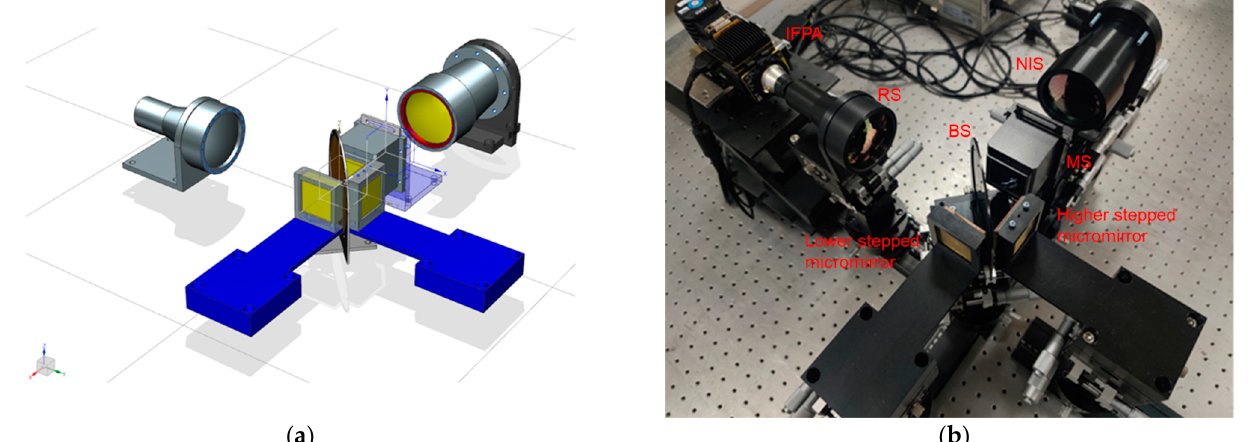
Figure 15. SIIFTS prototype: ( a ) the designed mechanical structure of the SIIFTS prototype; ( b ) a picture of the prototype of SIIFTS in a laboratory environment.